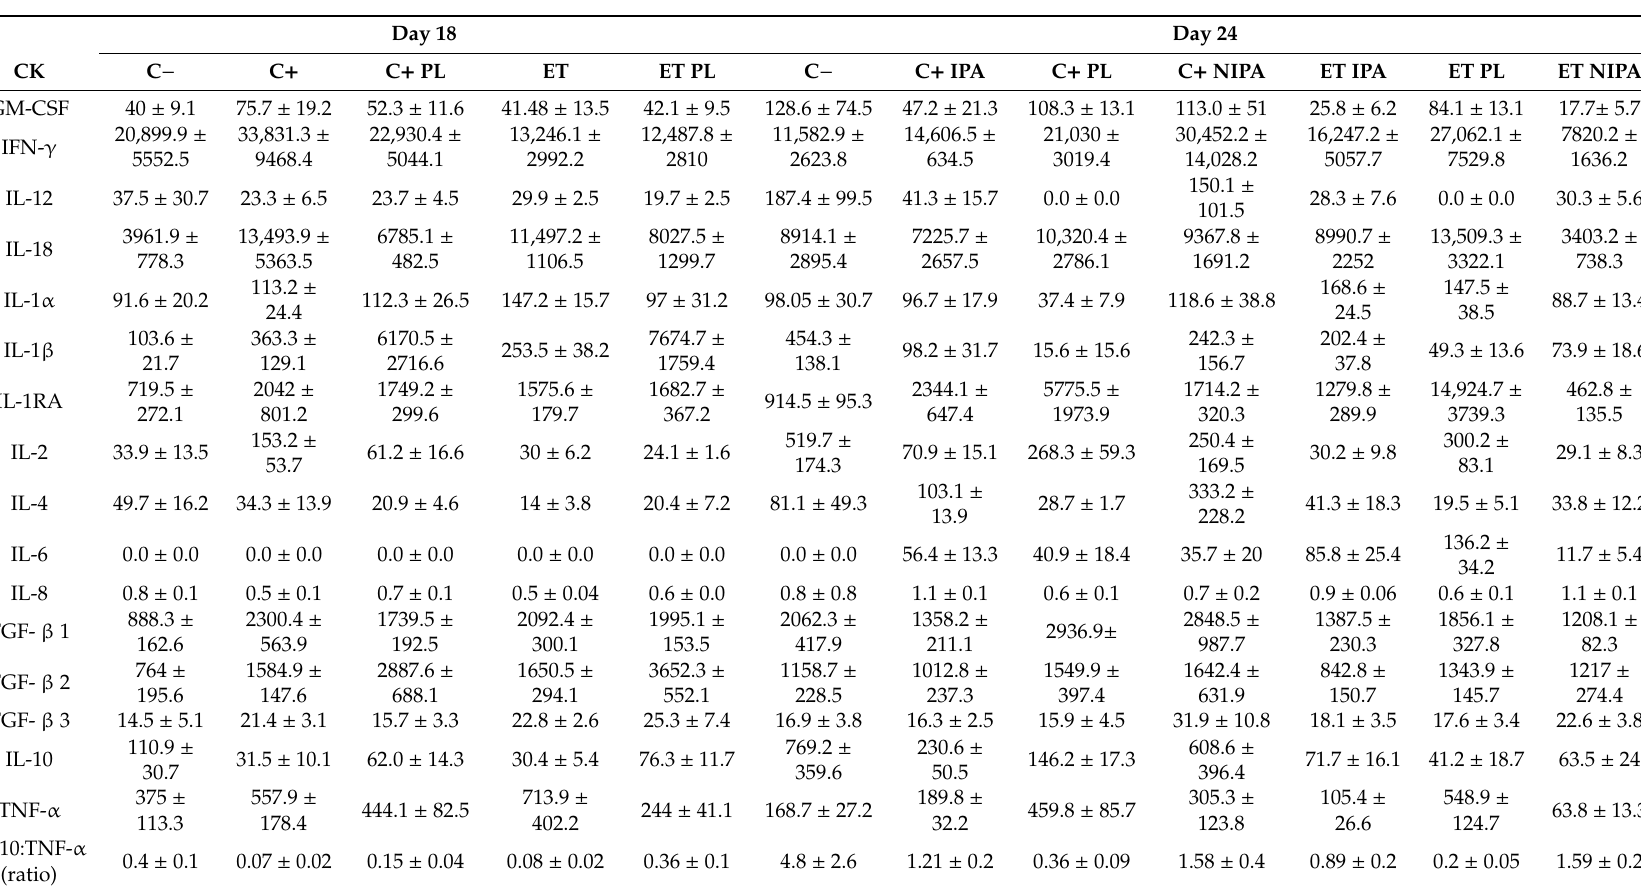
Table 2. Levels (pg / mg of total protein) of GM-CSF, IFN- γ , IL-12, IL-18, IL-1 α , IL-1 β , IL-1RA, IL-2, IL-4, IL-6, IL-8, TGF- β 1-3, IL-10, TNF- α , and IL-10:TNF- α ratio i n sows carrying hemi-allogeneic embryos (C + , n = 4), allogeneic embryos (ET, n = 4), and negative controls (not-pregnant, C − , n = 4) in samples of endometria (ET, C + : implantational areas) or NIPA (not-implantational areas) and fetal placenta (PL) at the peri-(D18) or post-implantation (D24) periods. Data are shown as Mean ±